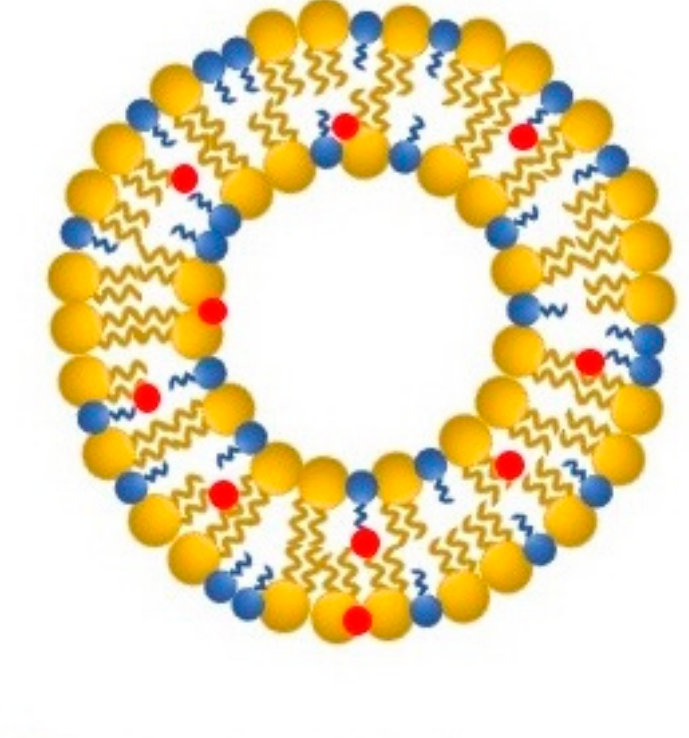
Figure 4. Schematic structure of transfersomes lipid vesicular system.